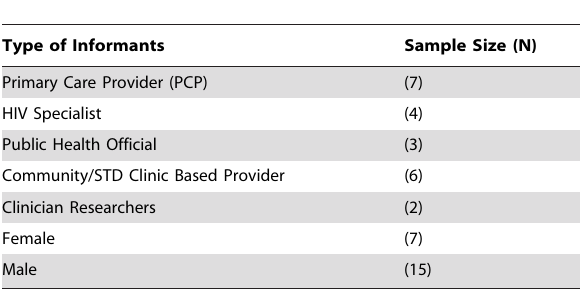
Table 1. Informant